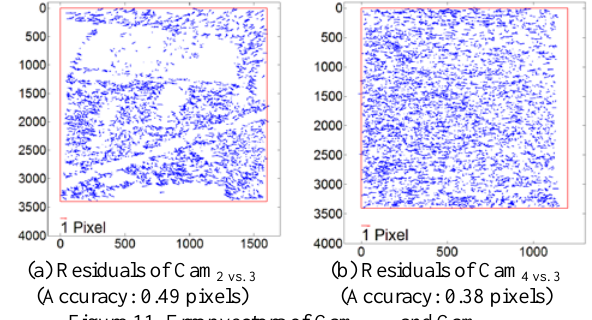
Figure 11. Error vectors of Cam 2 vs. 3 and Cam 4 vs.